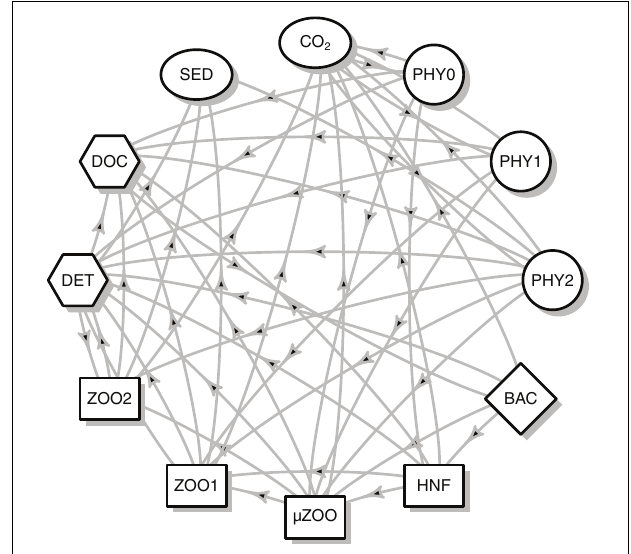
FIGURE 2 | Food web topology of the linear inverse models. The same topology was used for all stations. Arrows represent carbon flows between compartments. Autotrophic compartments are in circle: PHY0, pico autotrophs < 3 µ m; PHY1, nano autotrophs 3–10 µ m; PHY2, micro autotrophs > 10 µ m including colonial Phaeocystis . Diamond: BAC, heterotrophic bacteria; Heterotrophic grazers are in rectangles: